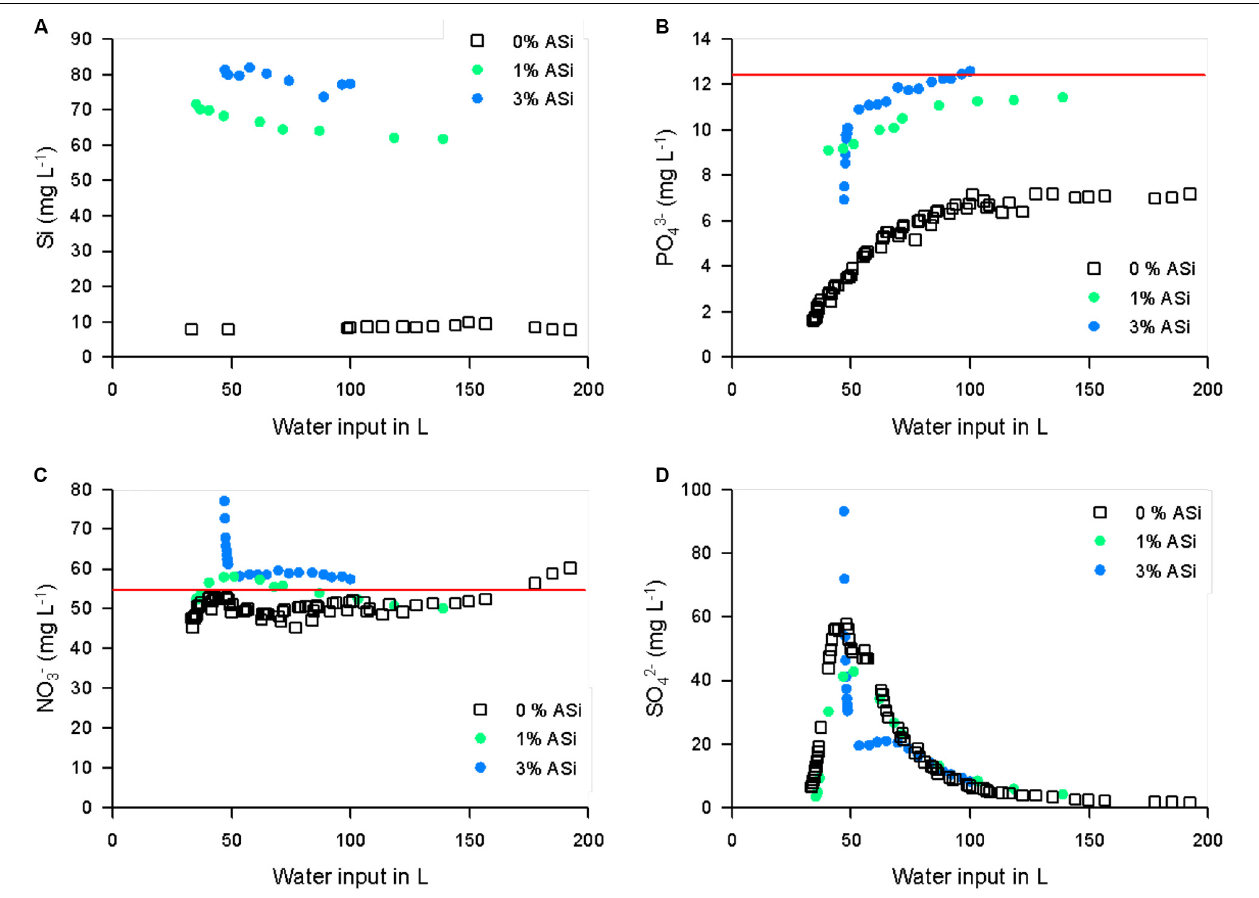
FIGURE 6 | Silicon (A) , phosphate (B) , nitrate (C) , and sulphate (D) concentration in the seepage water in relation to water input for different soil ASi content. The red line indicates the concentration of the irrigation